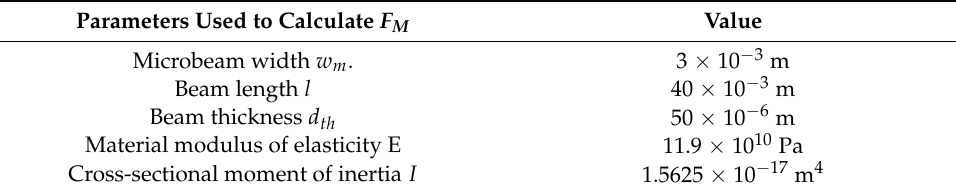
Figure A2. Schematic showing of the beam deformation under the action of external force F E and restraining force F N : ( a ) the constraint of the beam; ( b ) deformation of the beam under the action of external force F E ; ( c , e ) deformation of the beam under the action of restraining force F N ; ( d , f ) deformation of the beam under the combined action of restraining force F N and external force F E . The solid line represents the initial state, and the dotted line represents the deformation state.